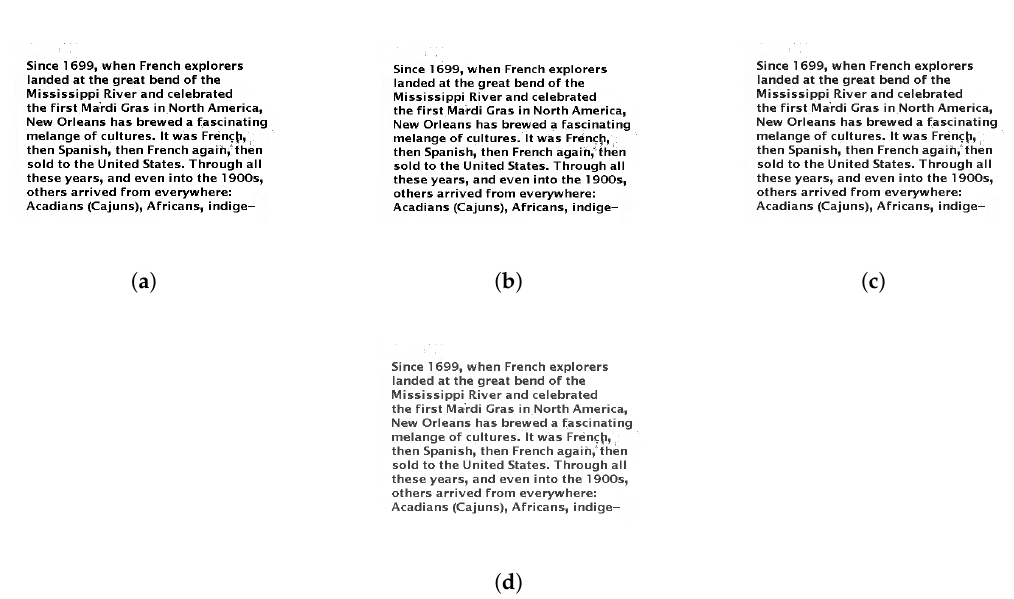
Figure 8. Restoration results of different algorithms for text in Figure 6. ( a ) reconstructed text obtained by framelet+APG; ( b ) reconstructed text obtained by framelet+ADMM; ( c ) reconstructed text obtained by wavelet+APG; ( d ) reconstructed text obtained by wavelet+ADMM.